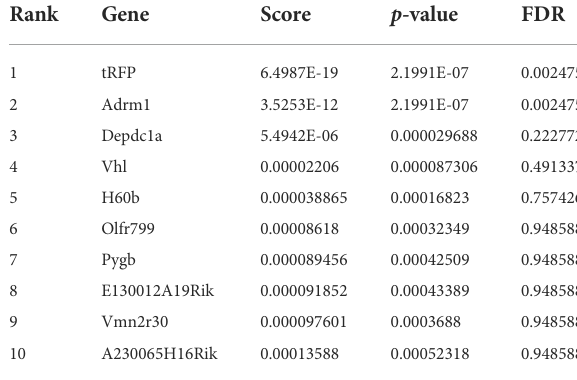
TABLE 3 Genes enriched in RP Down.